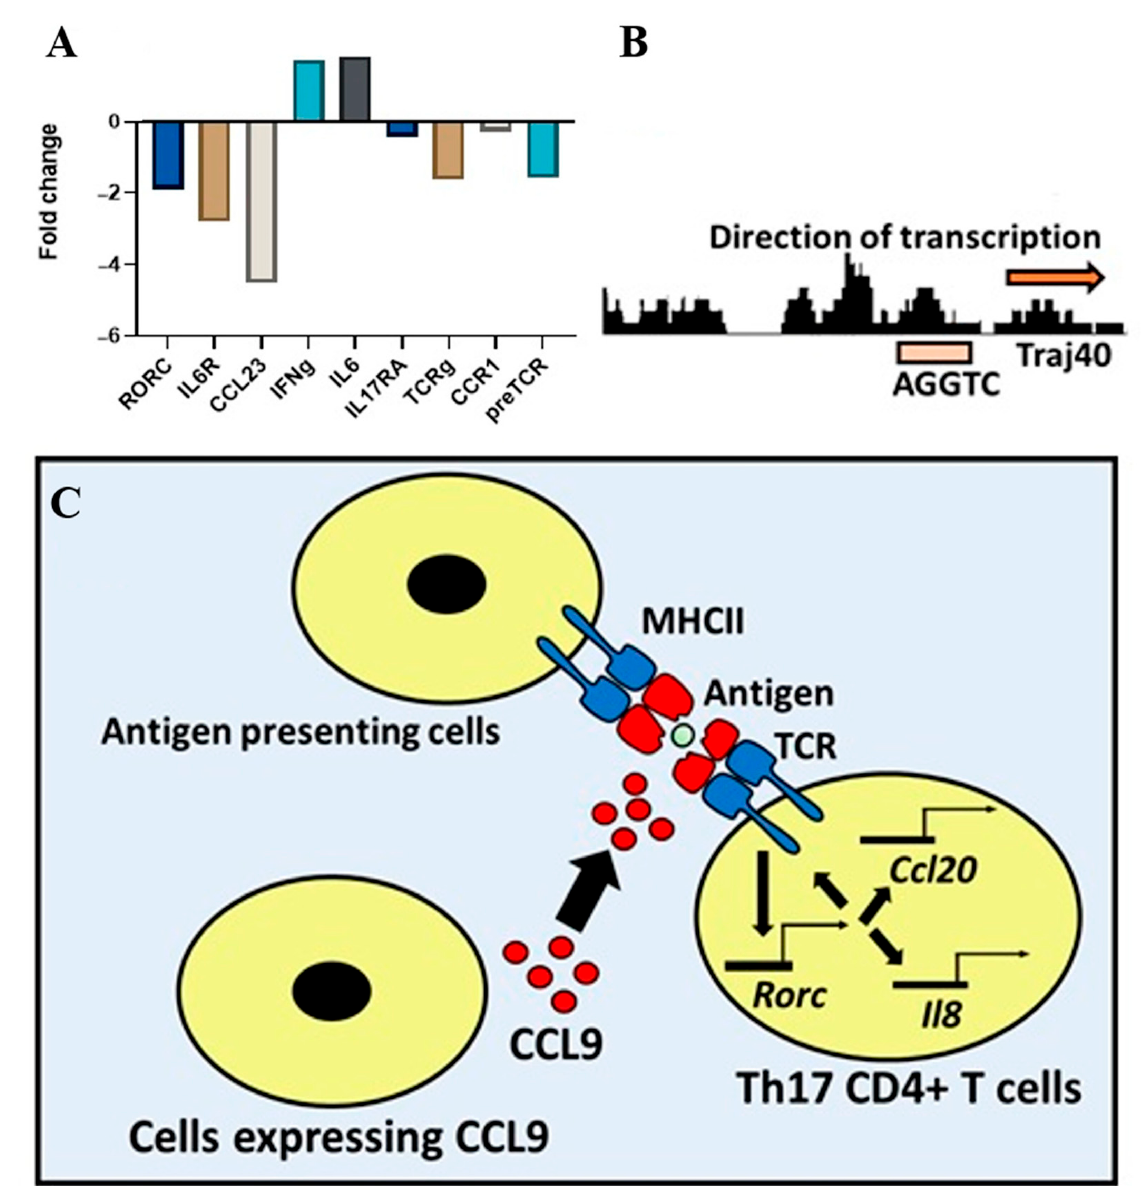
Figure 8. Microarray-based analysis suggests the involvement of CCL9 in CD4+ Th17 cells recruit- ment/activation in colon cancer. ( A ) Human microarray (GSE136735 on GEO repository) analysis of colorectal tissue versus normal tissues indicated downregulation of ROR γ t, CCL23, IL17RA, and TCRG (TARP) gene values in colorectal cancer samples, as shown in the bar plot. Interestingly, CCR1 (i.e., CCL23 receptor in humans) expression was not significantly altered in colon cancer tissue as compared to normal tissue, suggesting that the CCL9 effect on cancer growth might not be CCR1- mediated; ( B ) our analysis of ChIP seq-data published in Ciofani et al. identified ROR γ t response element motif AGGTCA in the promoter of Traj40 in Th17 cells [20]. This observation indicates that there might be an auto-regulation loop between ROR γ t and the genes controlling TCR receptor func- tion/diversification. ( C ) The data hints at a possible role for CCL9 in the activation/recruitment of pro-inflammatory Th17 cells, known to be beneficial in slowing tumor growth. A seemingly feasible hypothesis of CCL9 function could be that it plays a role in increasing TCR activation in ROR γ t+ T cells (i.e., Th17 cells) through a Gq-mediated pathway. In turn, Th17 cells could promote CD8 and neutrophil recruitment, thereby decreasing tumor growth. However, our data do not exclude a positive effect of CCL9 on other ROR γ t+ T cells, such as ROR γ t+ CD8 (also known as